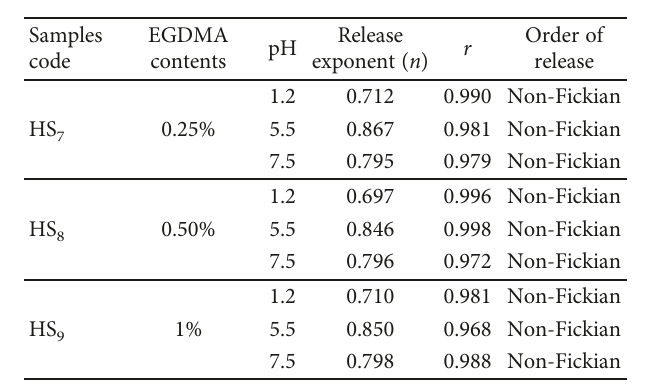
Table 8: E ff ect of degree of crosslinking on the drug release mechanism of Poly (CMCS- g -AA) hydrogels in solutions of di ff erent pH.